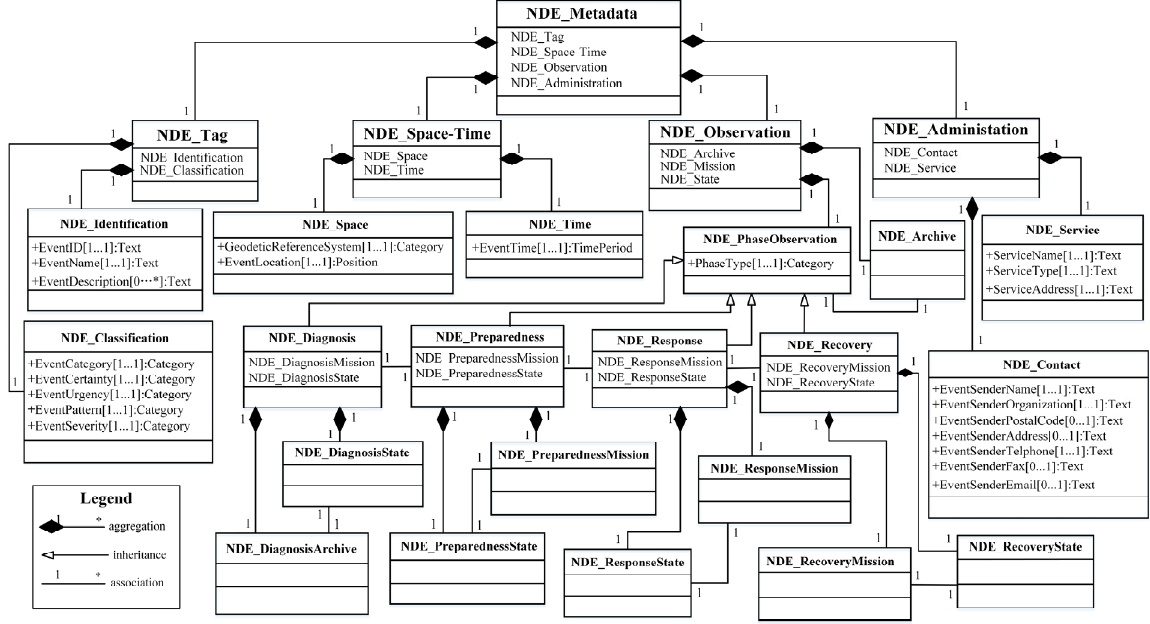
Figure 4. The Resultant of Full Life Cycle Natural Disaster Event Metamodel